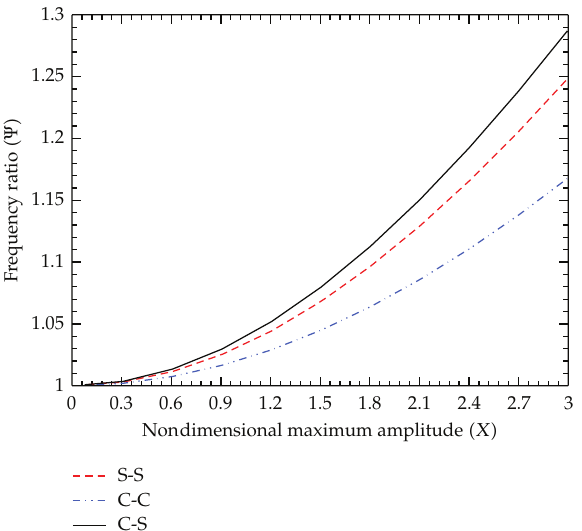
Figure 5: Nondimensional frequency ratio against nondimensional maximum amplitude of TWNTs under various boundary conditions (cid:3) k (cid:8) 10 7 N/m 2 (cid:4)